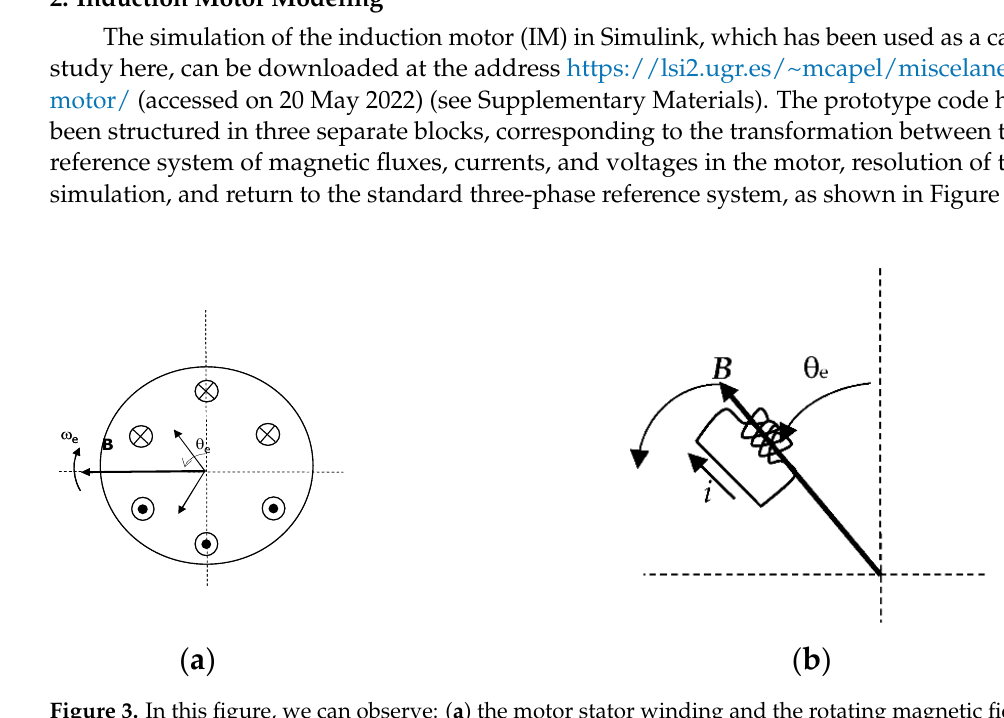
Figure 3. In this figure, we can observe: ( a ) the motor stator winding and the rotating magnetic field it produces; ( b ) the induction motor model with only one rotating coil at the speed ω e of the rotating field B .